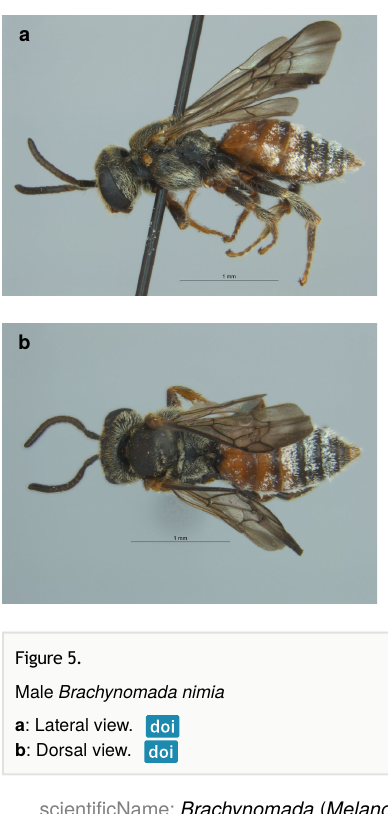
Figure 5. Male Brachynomada nimia a : Lateral view. b : Dorsal g. scienti fi cName: Brachynomada ( Melanomada ) nimia (Snelling and Rozen, 1987);